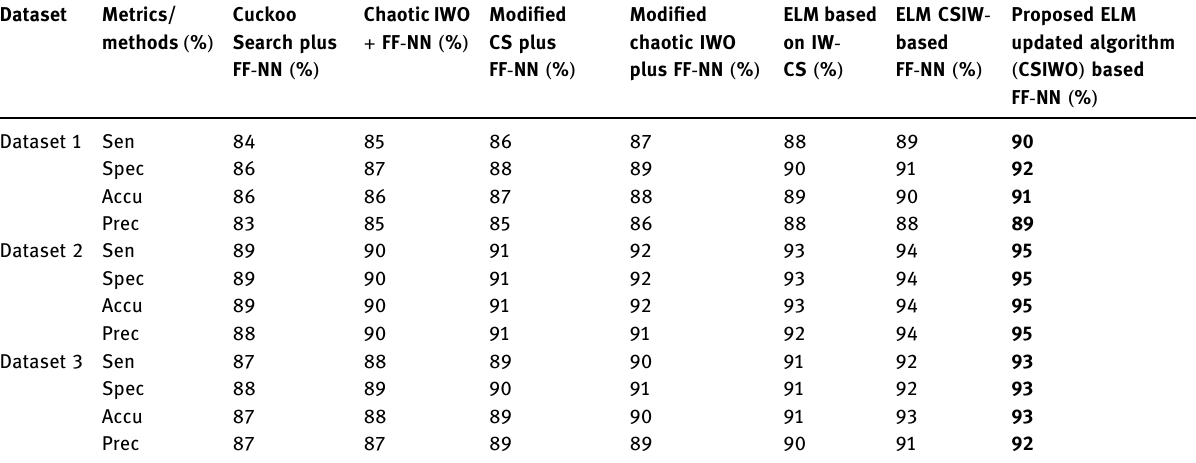
Table 3: Comparative discussion for optimization value function